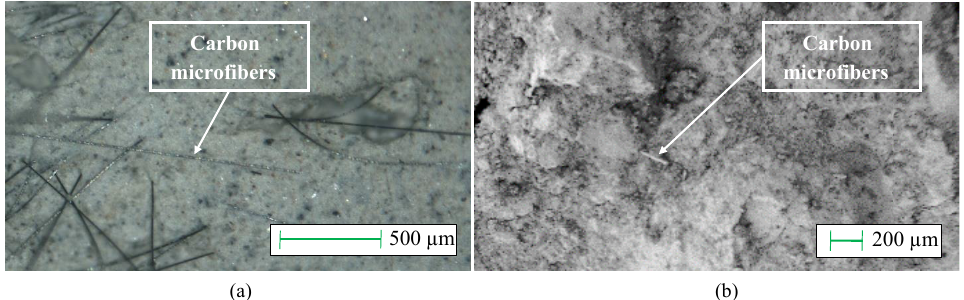
Figure 2. ( a ) Optical microscope and ( b ) scanning electron microscope inspections on fragments of hardened